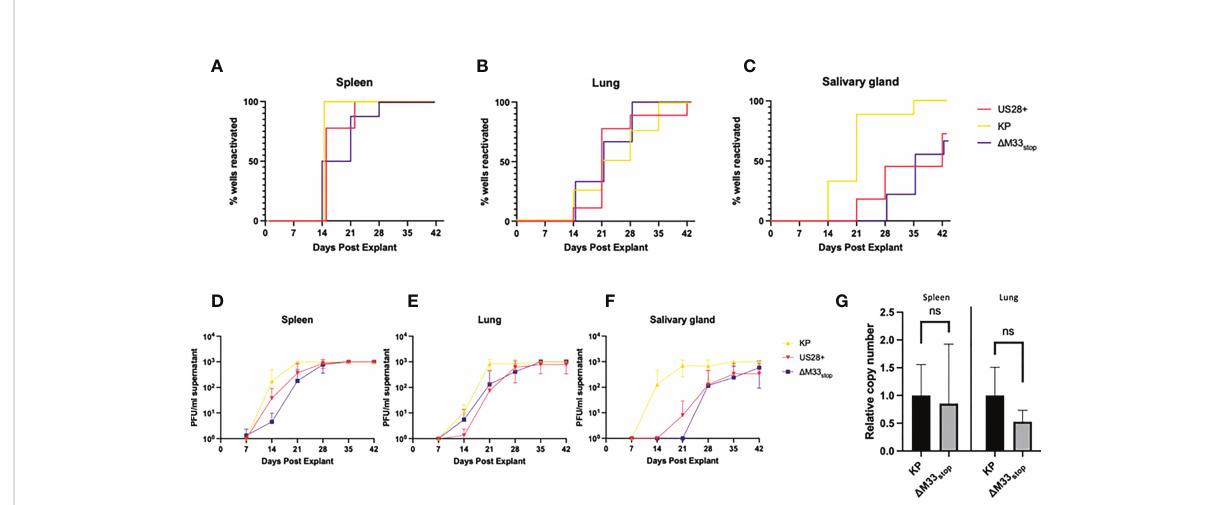
FIGURE 2 KP and D M33 stop MCMV reactivation ex vivo. Mice were infected I.P. with 10 6 PFU of KP, US28 + , or D M33 stop MCMV. At 70 dpi, mice were sacri fi ced and tissues were explanted. (A-C) US28 + (red line), D M33 stop (purple line) and KP (gold line) are shown in the spleen (A) , lung (B) , and salivary gland (C) . (D-F) Titers of virus from explant supernatant in the spleen (D) , lung (E) , and salivary gland (F) shown in PFU/ml. (G) Viral genome copy number, normalized to cell genome number, shown relative to wild-type KP (p>0.2). Data represent 5 animals, with each tissue divided into 3 wells (A-F; n=5) or 3 animals (G) . Statistical test used in (G) is Student T test. Statistics shown as: ns, not signi fi